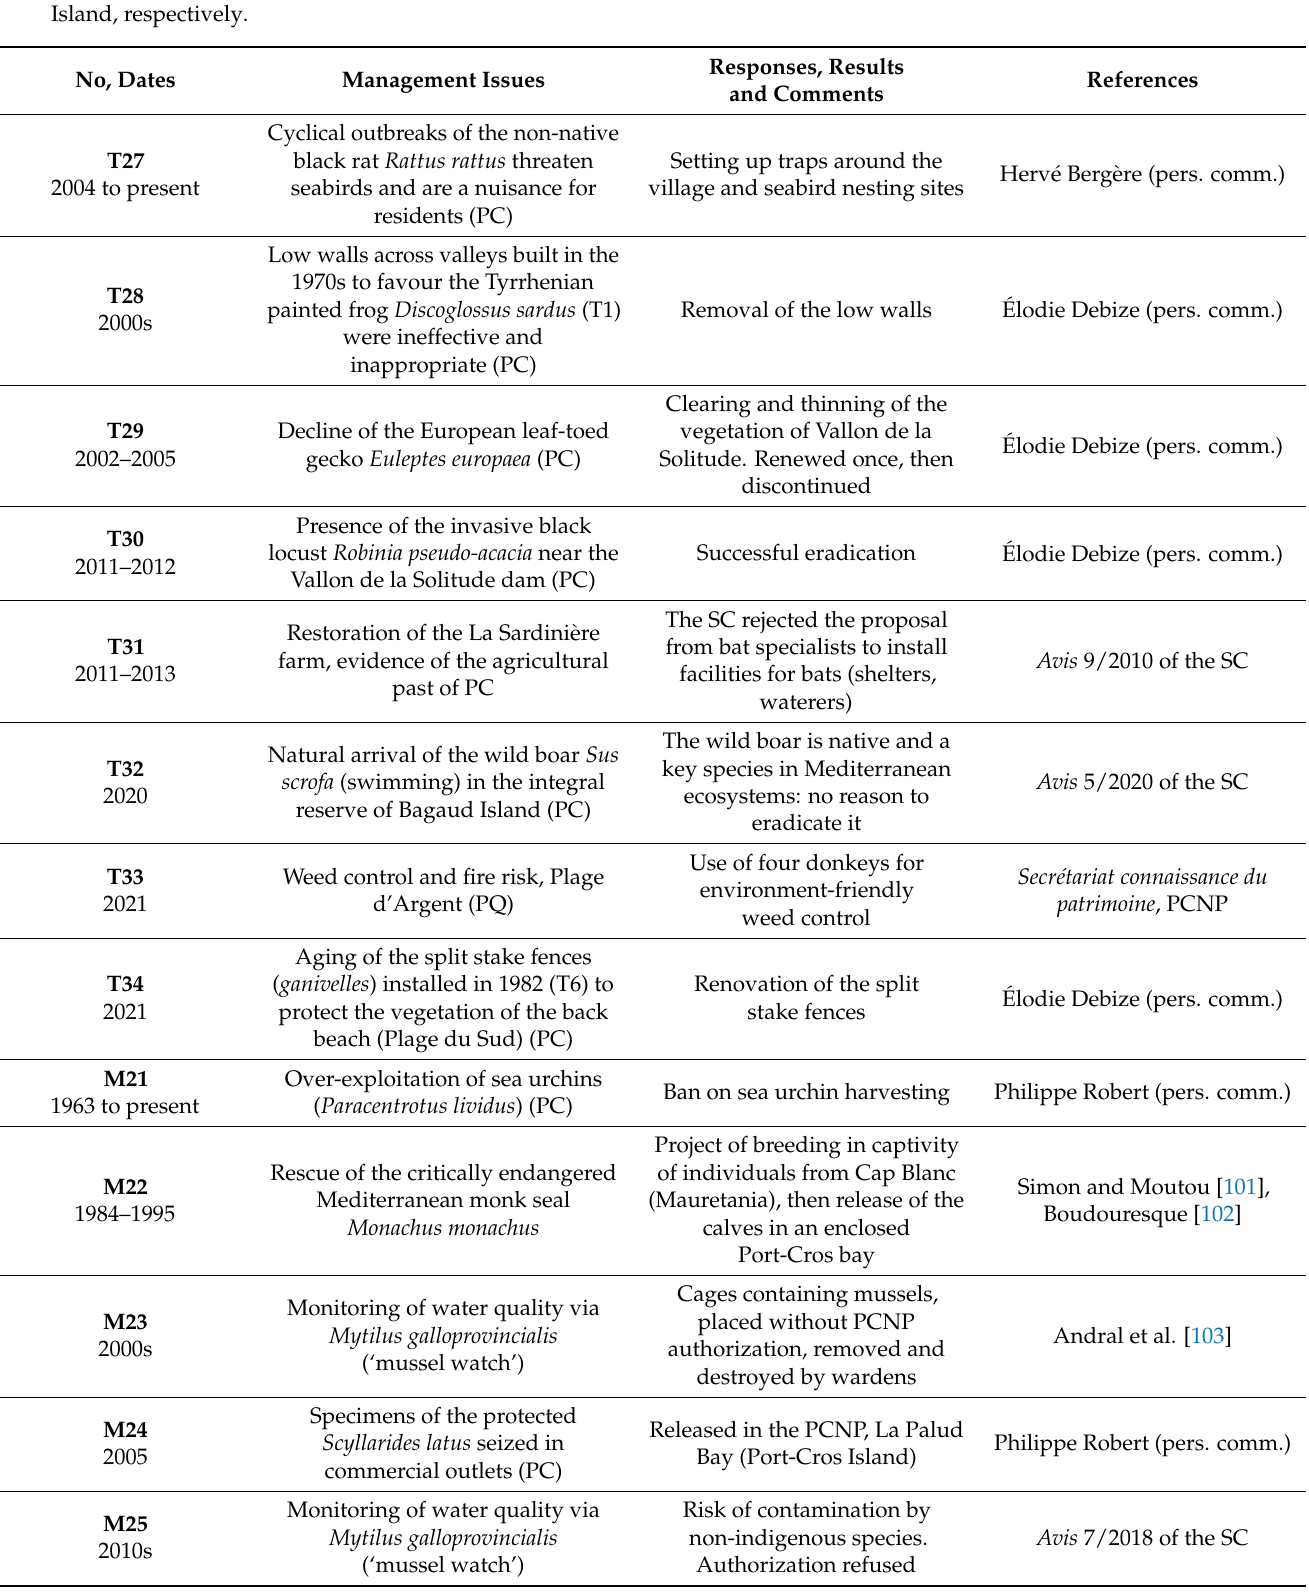
Table 1. Management issues and responses from the PCNP and N-PCNP in the terrestrial realm (numbered T27 through T34) and the marine realm (numbered M21 through M29). These operations were not taken into account by Boudouresque et al. ([92]; see Tables 1 and 2 herein). PC and PQ refer to Port-Cros Archipelago and Porquerolles Island,